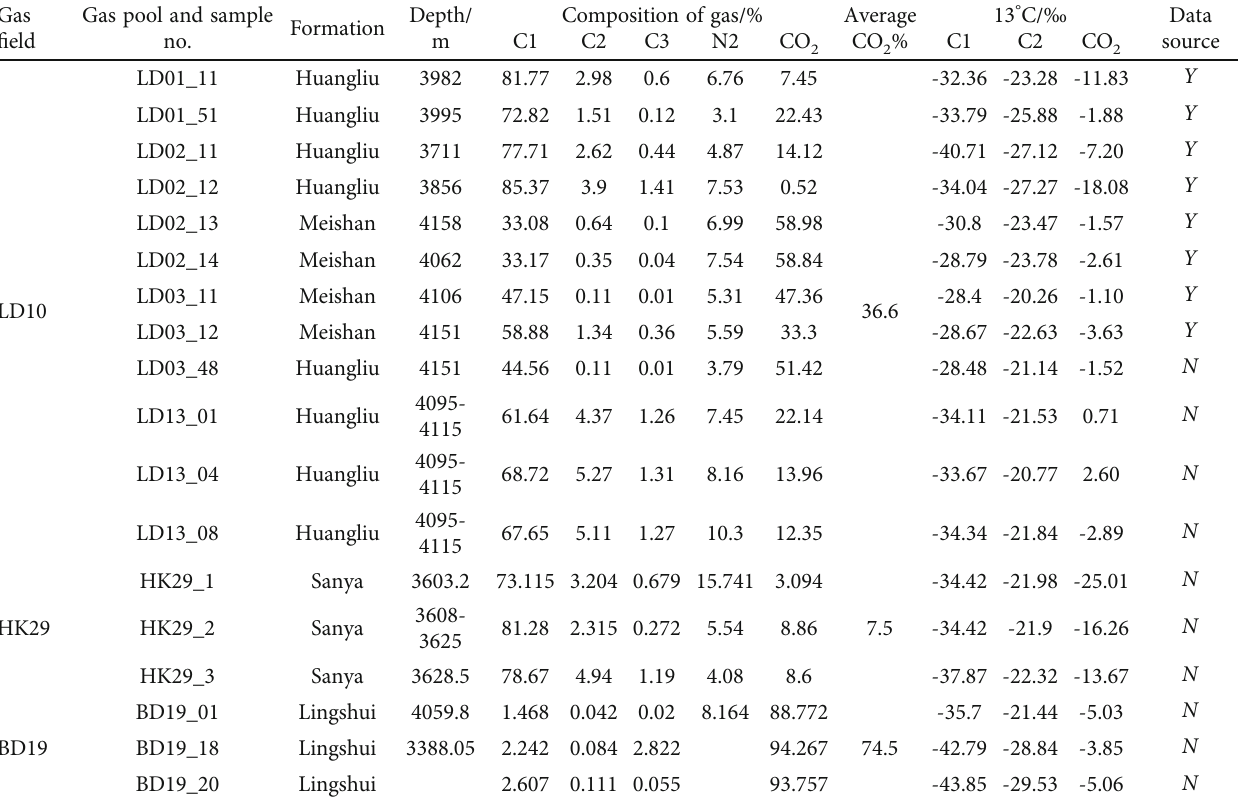
Table 1: Sampling location and characterization of inclusions in the three gas reservoirs. Describe The inclusions are oval in shape and generally 3-9 μ m in size. These inclusions are mainly distributed in the fractures of quartz particles, accounting for about 5% of the sample. It is nearly round, 4-15 μ m in size, colorless, and often associated with saline inclusions. and 2-5 μ m are mostly small inclusions. The inclusions are mainly gaseous hydrocarbon brine inclusions are 50-60%, with a small amount of CO inclusions. 2 Table 2: Chemical and carbon isotopic compositions of natural gas generated in three gas